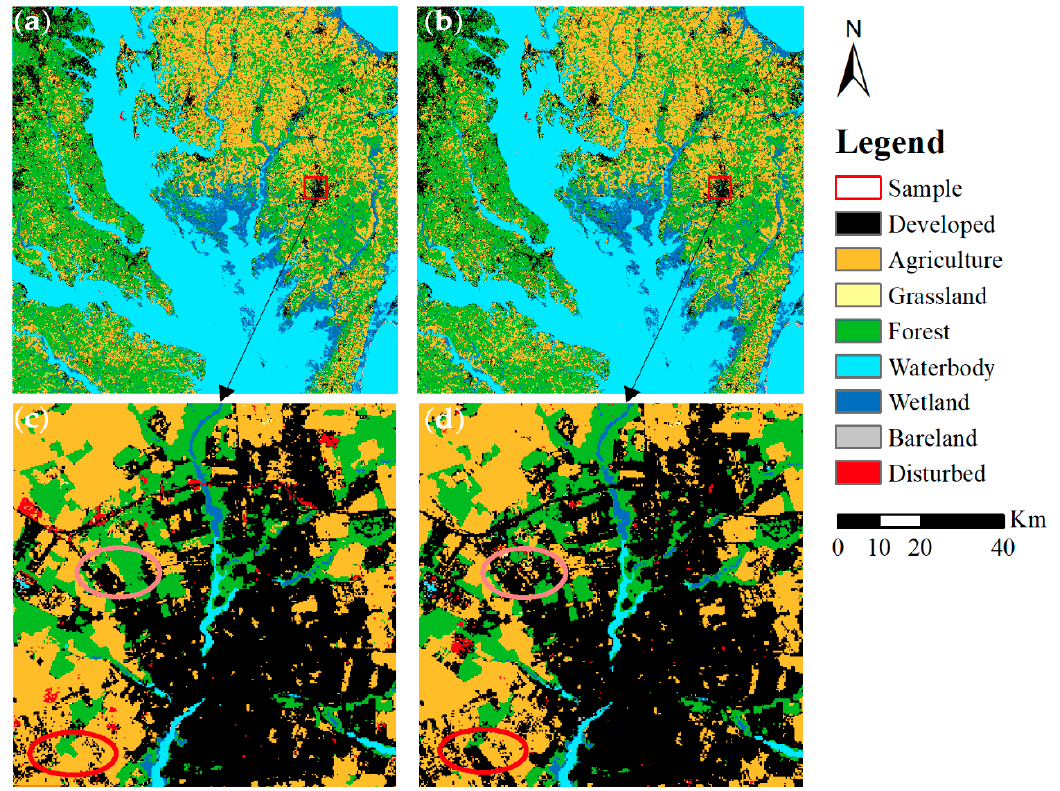
Figure 3. Comparison of LULC for LCMAP in 2001 and 2011. ( a ) shows land cover in 2001, with ( b ) land cover in 2011. ( c ) and ( d ) are zoomed-in figures of interest areas in ( a ) and ( b ), respectively. Ovals in ( c ) and ( d ) show the process of urbanization (pink ovals show conversion from forest and red ovals the conversion from forest and agriculture to urban land use).